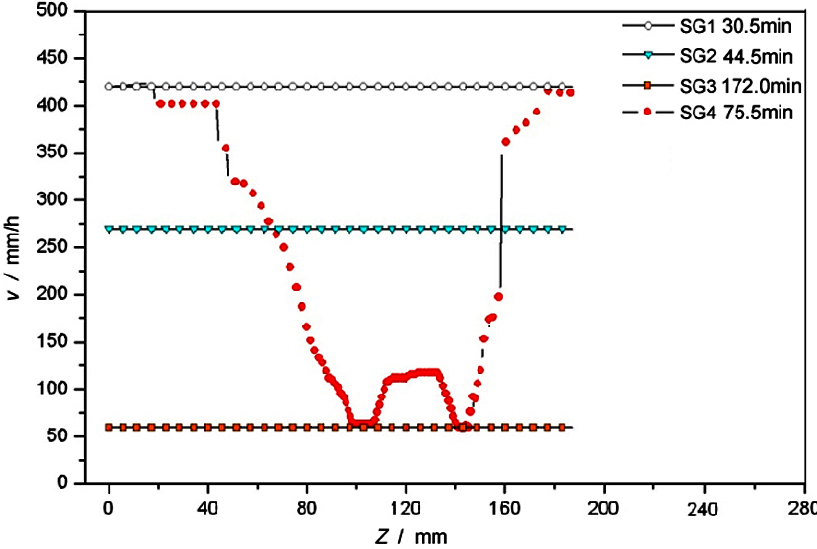
Figure 5. Curves of withdrawal rates of SG1–SG4.